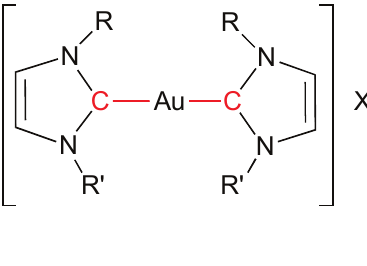
Figure 2. N , N -heterocyclic bis(carbene) gold mesogens. R = C R ' = CH C(O)NH . X = Br, NO 2 2